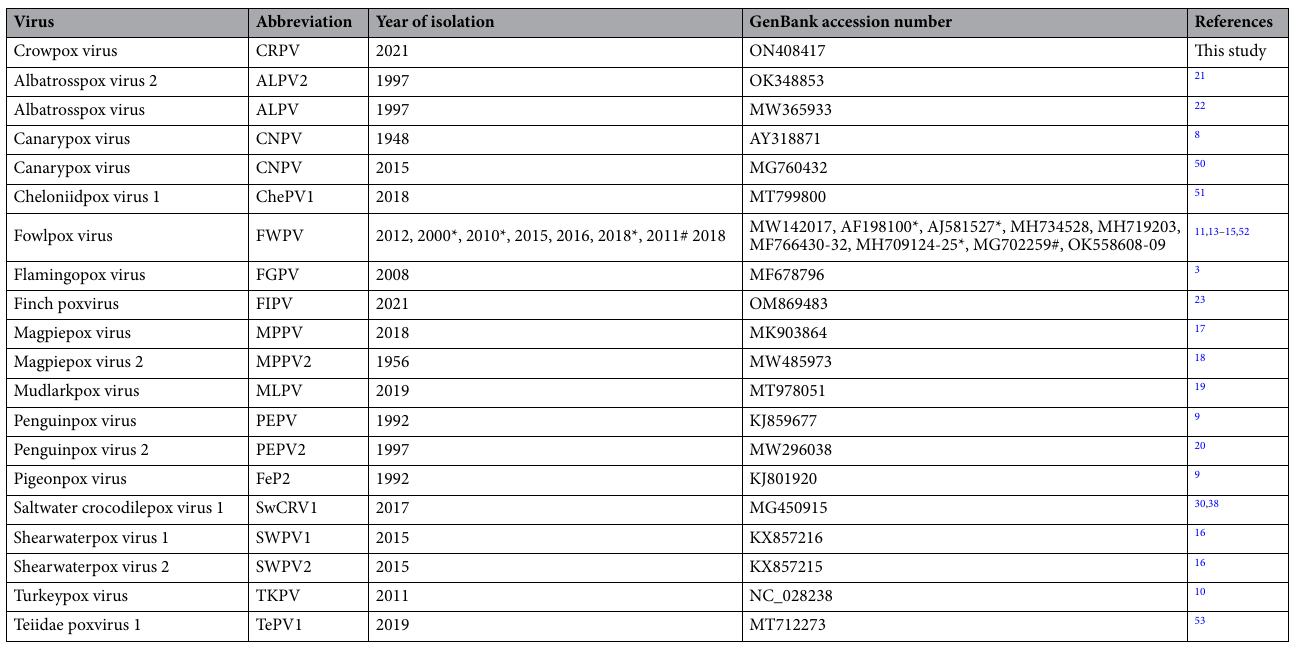
Table 3. Related poxvirus genome sequences used in further analysis of CRPV. * = the year of submission to GenBank is reported, # =